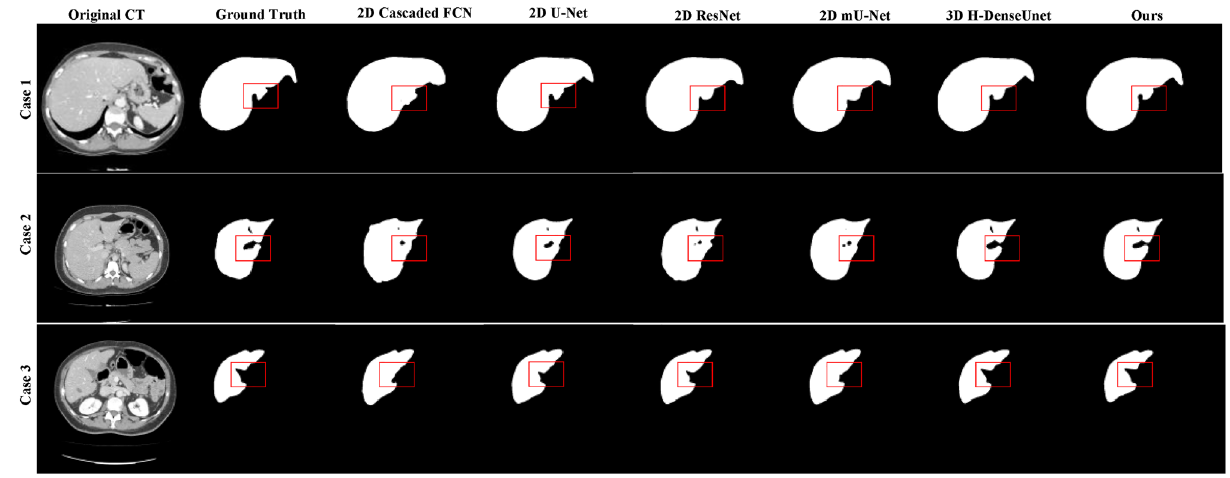
Figure 6. Three typical segmentation results of different SOTA methods on the 3DIRCADb test datasets.